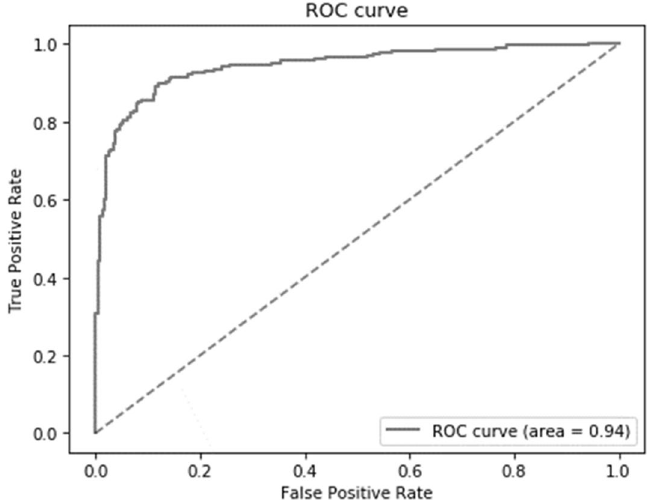
Figure 1. The ROC curve of the diagnostic accuracy of the deep learning algorithm is shown. ROC, receiver operating